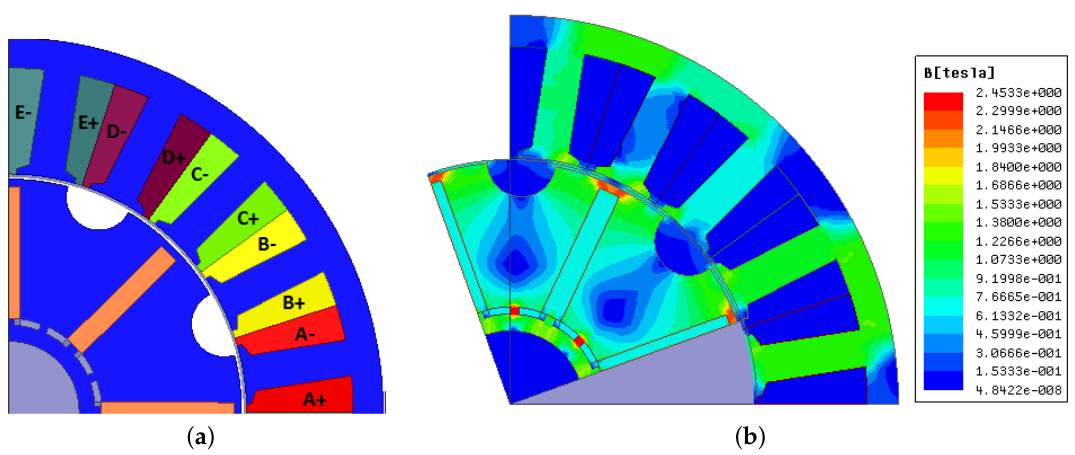
Figure 1. ( a ) Representation of the original bi-harmonic machine with 5 phases/20 slots/8 poles; ( b ) magnetic flux density map at no